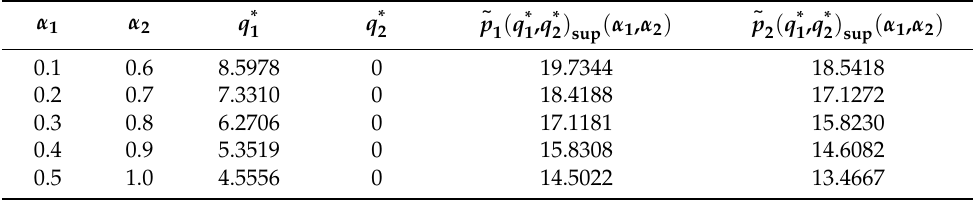
Table 7. ( α 1 , α 2 )-optimistic equilibrium quantity for Scenario II when the risk aversion levels for CDT and AG